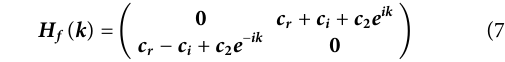
– F) Are the distributions of eigenmodes